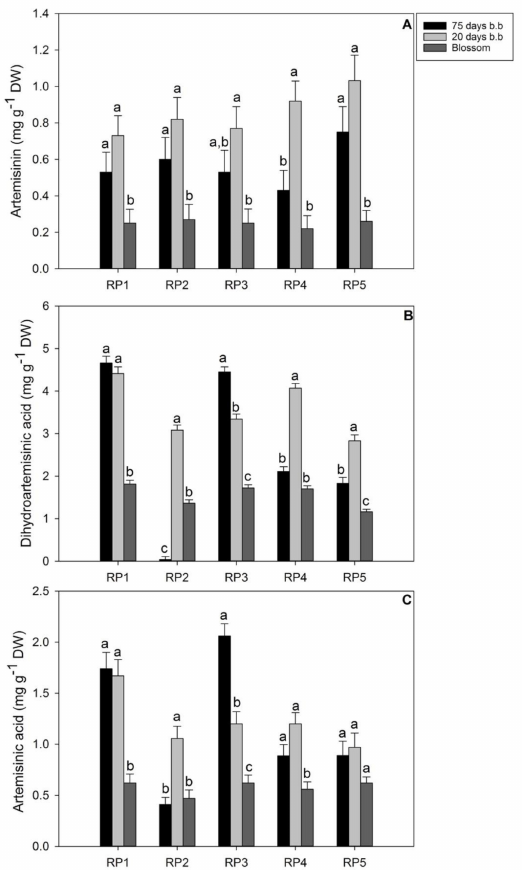
Figure 4. Artemisinin ( A ), Dihydroartemisinic acid ( B ) and Artemisinic acid ( C ) content in Artemisia annua regenerated plants (RPs) at different sampling times (b.b. = before blossom). Data are expressed as mg g − 1 DW and are means ± standard deviation of two independent replicates (n = 2). Data were submitted to one-way analysis of variance (ANOVA). Differences in the same groups were detected using multiple comparison procedures (Tukey test) and indicated with different